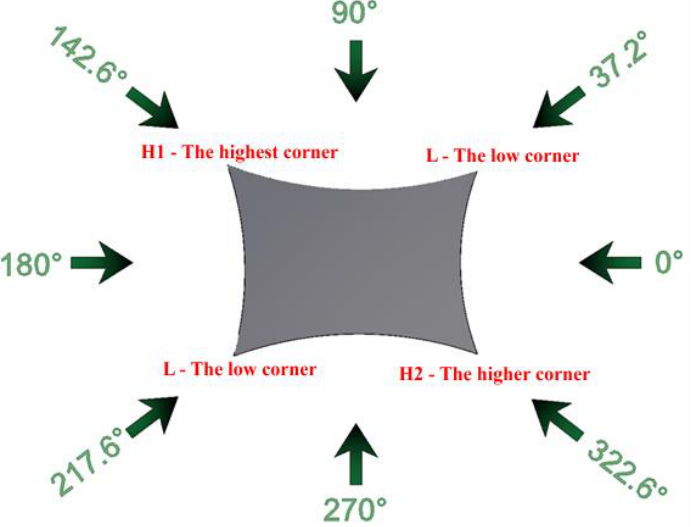
Figure 7. The direction of wind flow.